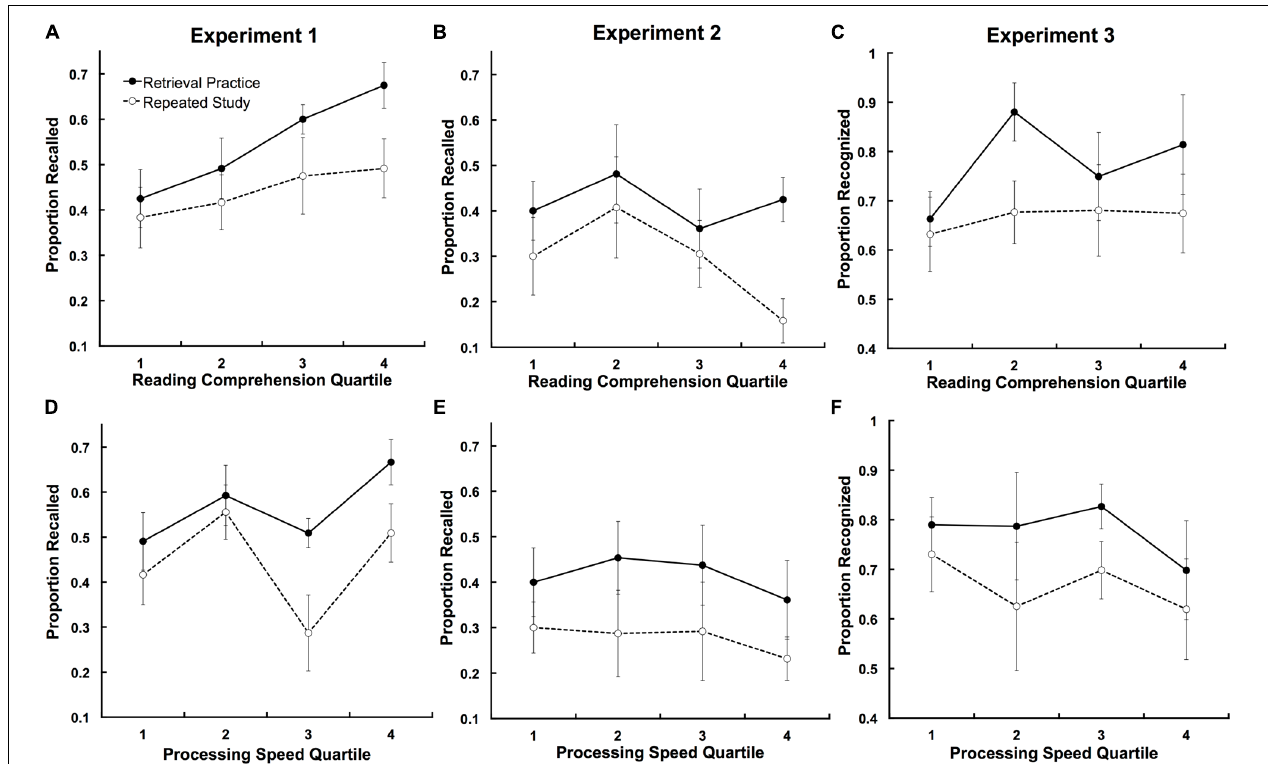
FIGURE 2 | Children’s retrieval practice and repeated study performance based on their reading comprehension and speed of processing. For illustrative purposes, children were divided into quartiles, 1 representing the lowest 25% of scorers, and 4 representing the highest 25% of scorers. Reading comprehension (A–C) was measured by the Maze test, and speed of processing (D–F) was measured by the Cross-Out task from the Woodcock–Johnson Tests of Cognitive Ability. Across the three experiments, children consistently benefitted from retrieval practice over repeated study and this effect was approximately the same regardless of reading comprehension and speed of processing.